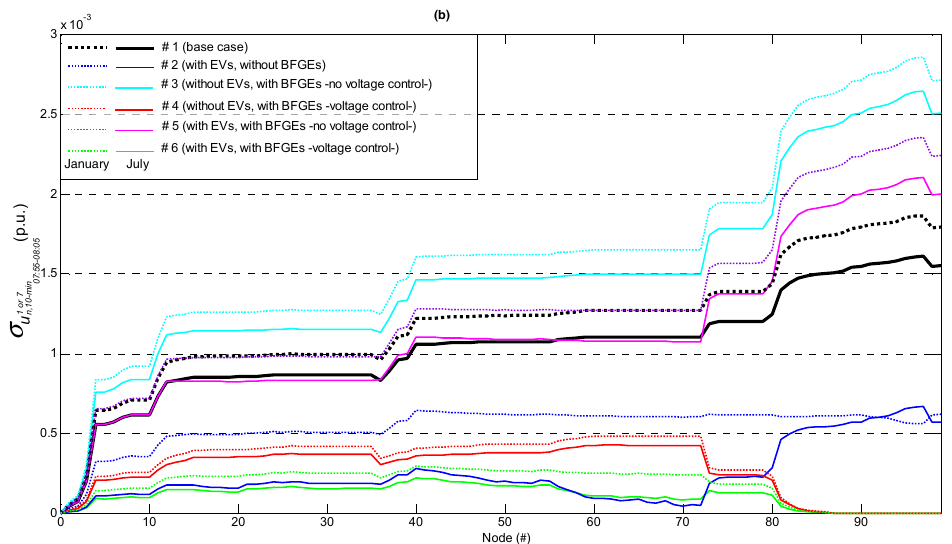
Figure 7. 10-min voltage magnitude during a working day in January and July for each RDS node in different scenarios around 08:00 h. ( a ) expected value; ( b ) standard deviation.